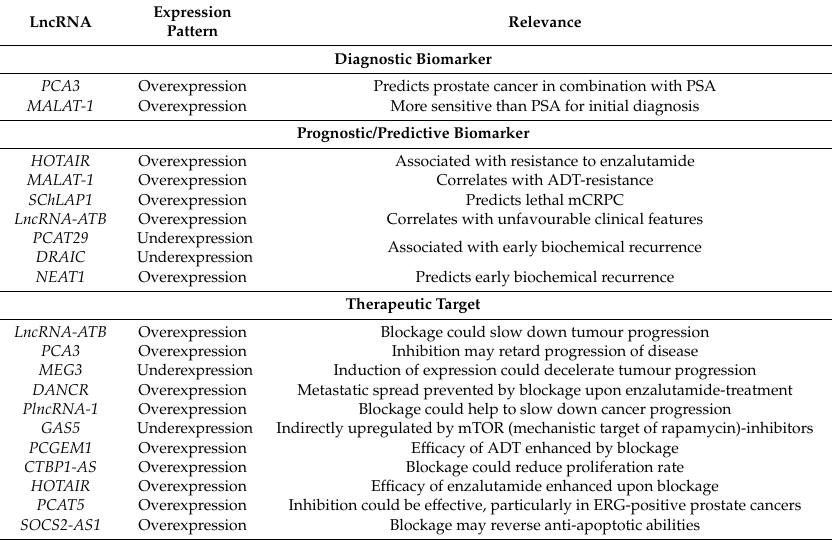
Table 1. Clinical usage of aberrantly expressed lncRNAs in prostate